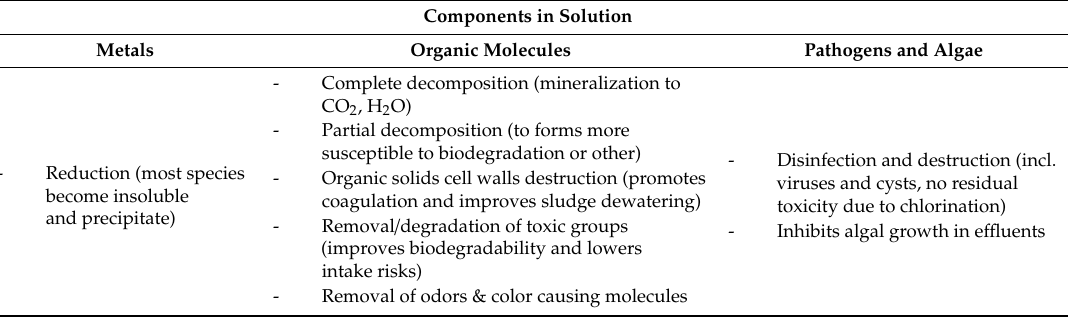
Table 3. Possible action mechanisms of EB-generated radicals in a water